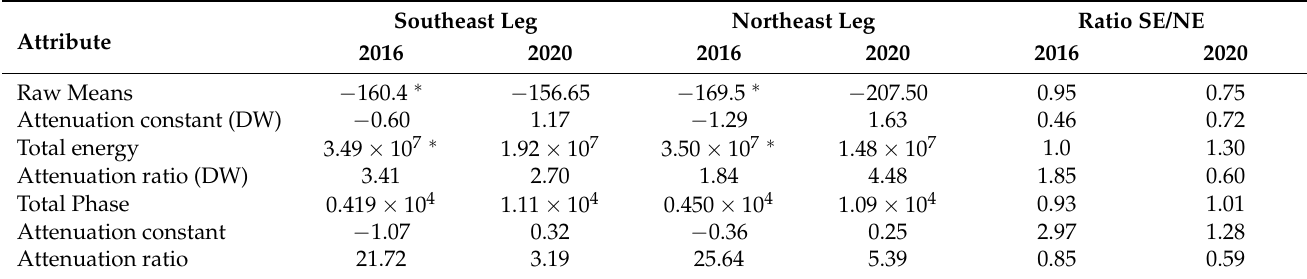
Table 5. Comparison of attribute values for southeast and northeast legs between 2016 and 2020 measurements. Note, ∗ represents normalized value to account for different